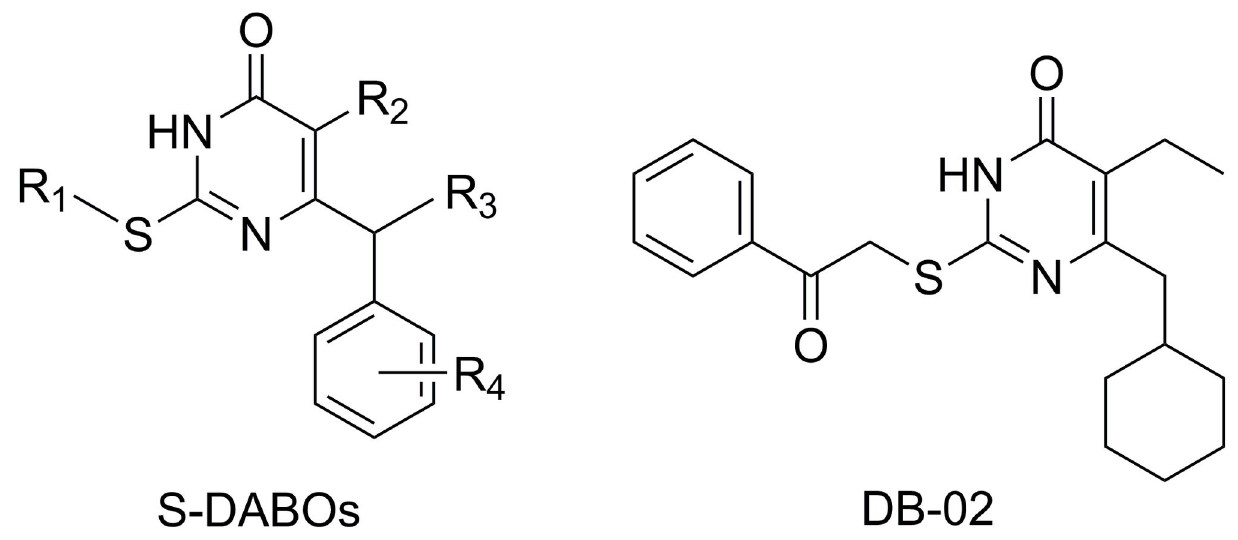
Figure 1. Structures of S -DABO and